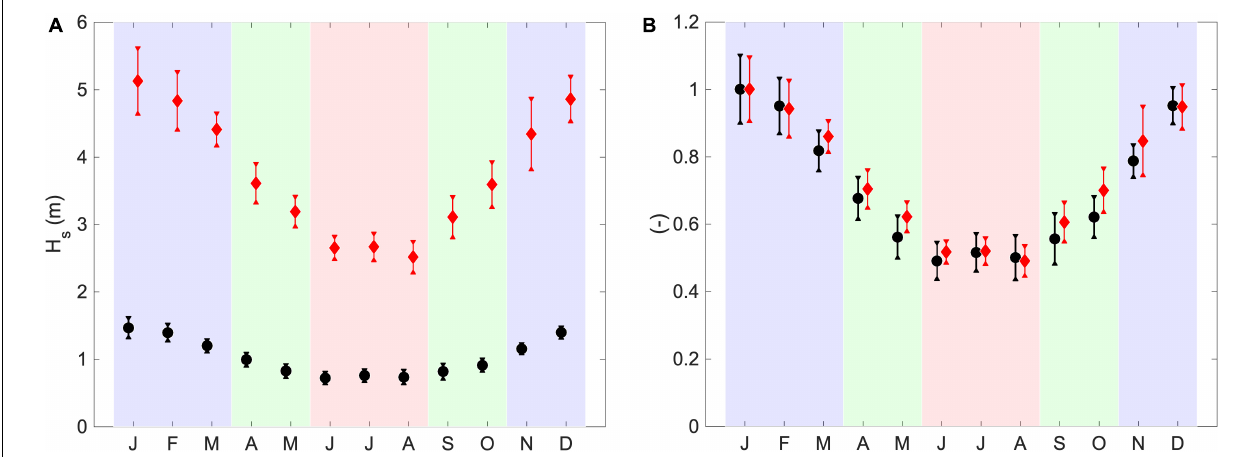
FIGURE 2 | Yearly-averaged monthly 50th (black dots) and 99th (red diamonds) percentiles of H s over the MS, from eight satellite altimeters (see Supplementary Table 1 ), dimensional [panel (A) ] and normalized with the maximum value [panel (B) ]. Dots and diamonds represent the ensemble average over the altimeter percentiles and bars represent the confidence intervals over the altimeter percentiles ( ± an ensemble standard deviation). Violet shading indicates winter months (NDJFM), red shading summer months (JJA) and green shading spring and autumn (transitional seasons; AM and